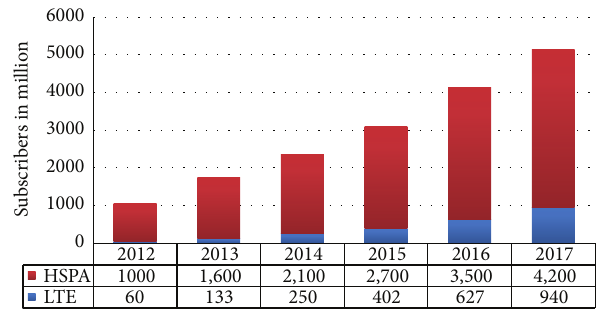
Figure 1: Growth forecasts for global HSPA and LTE subscribers,